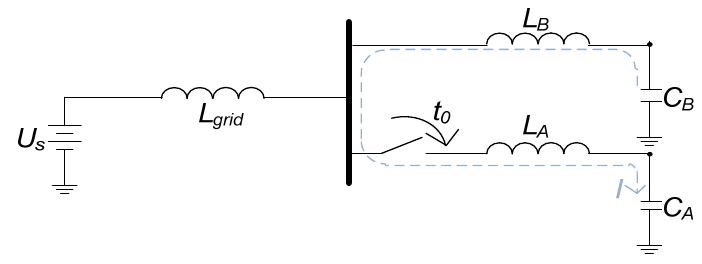
Figure 10. Simplified schematic of the connection of cable A to the already energised cable B, losses are neglected.